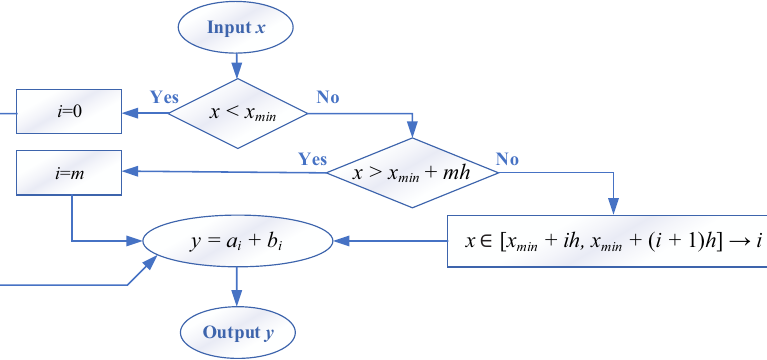
Figure 2. The algorithm with an approximated activation function.